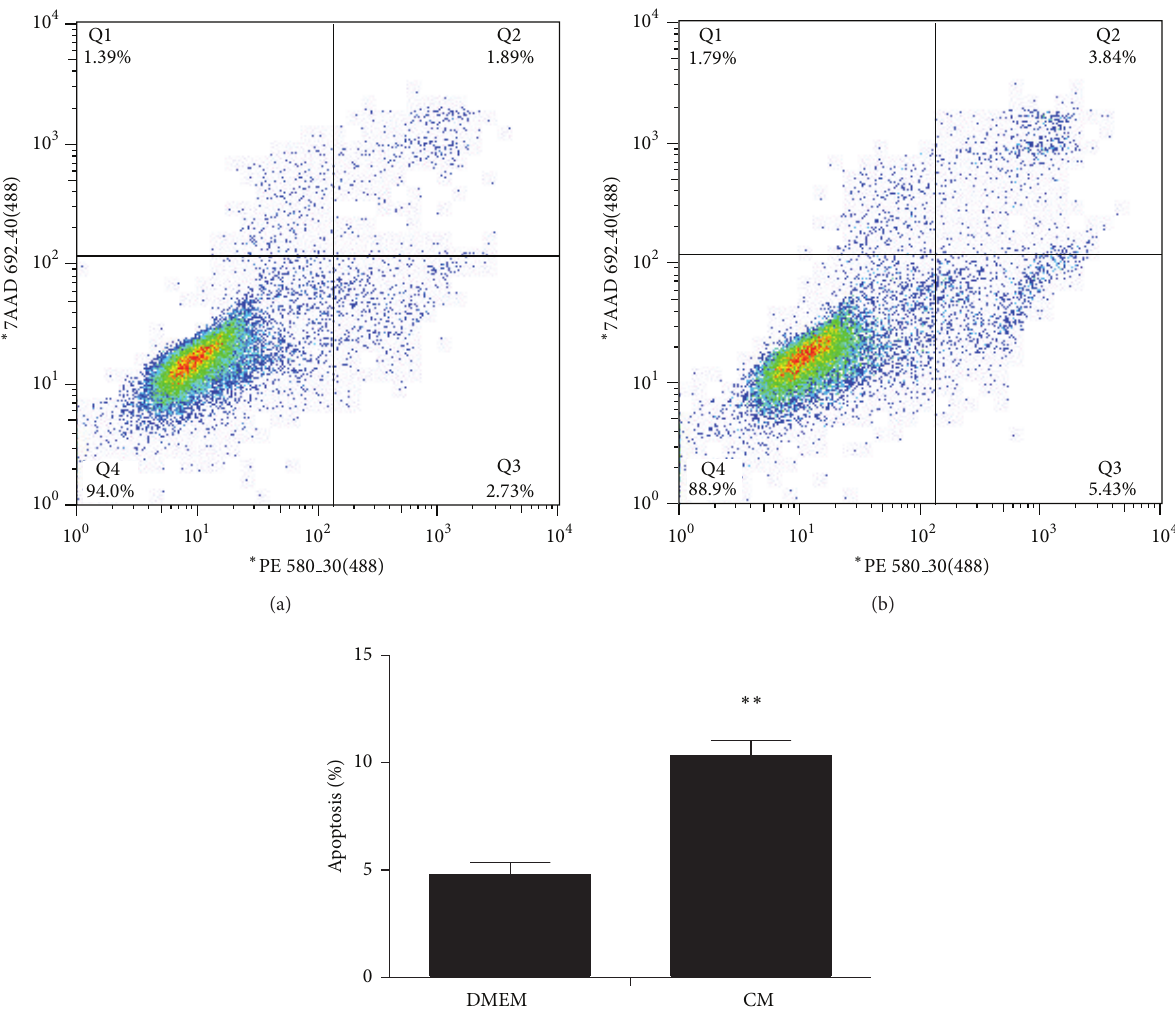
Figure 4: ADSC-CM treatment induces apoptosis in T24 cell line. Cells were double-stained with annexin V and PI and analyzed by flow cytometry. The gate setting distinguished between living (bottom left), necrotic (top left), early apoptotic (bottom right), and late apoptotic (top right) cells. T24 cells were treated with DMEM (a) as a control. Apoptosis was induced by ADSC-CM treatment (b). The apoptosis of T24 cells (c) was increased in the test group more than the control group from three independent experiments ( ∗∗ 𝑃 < 0.01 versus